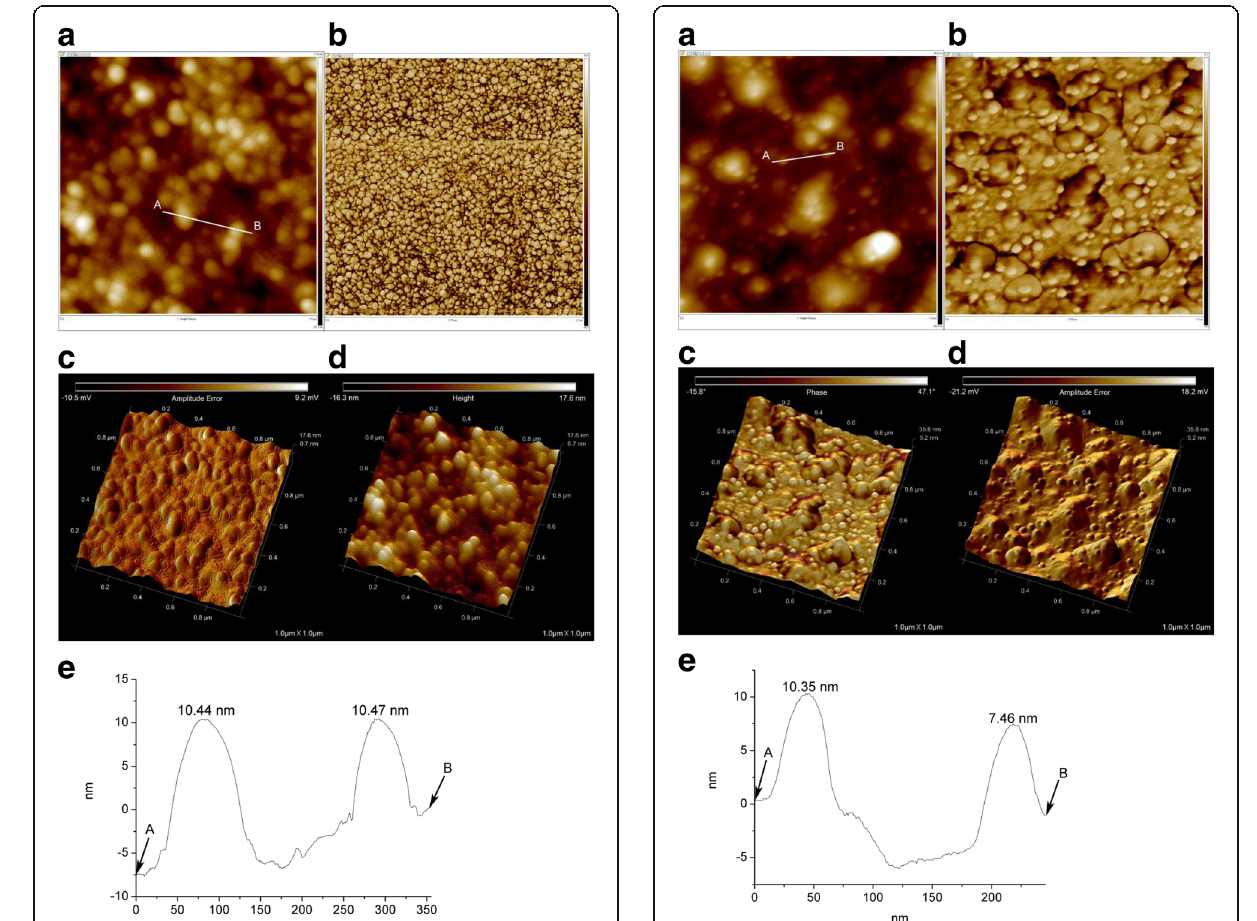
Fig. 6 AFM images and section analysis of PD-AgNPs. a 2D height (1 μ m×1 μ m). b 2D phase (1 μ m×1 μ m). c 3D phase (1 μ m×1 μ m). d 3D amplitude error (1 μ m×1 μ m). e Section analysis of line A-B in